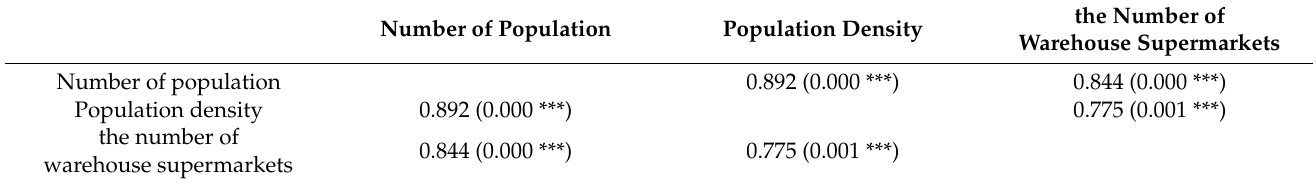
the Number of Warehouse Supermarkets